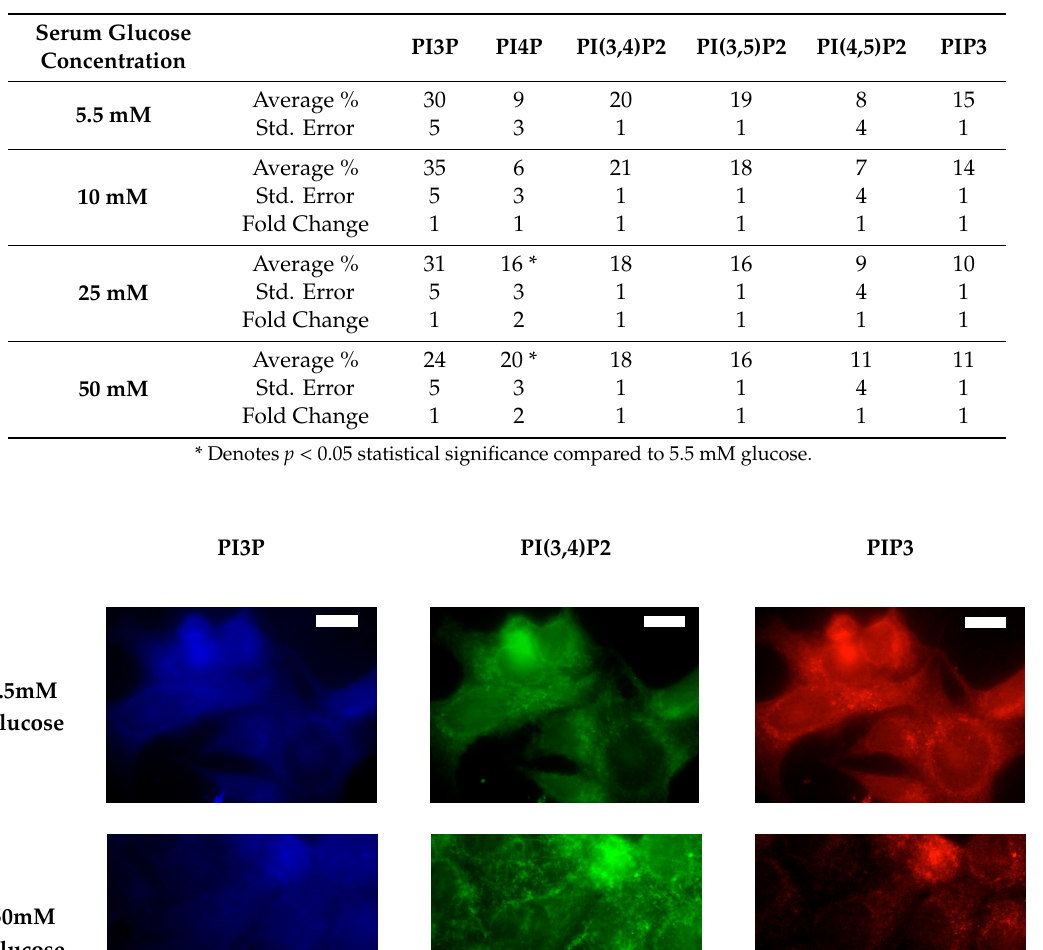
Table 2. Statistical analysis of whole cell lipidome in MCF7 Cell Line.